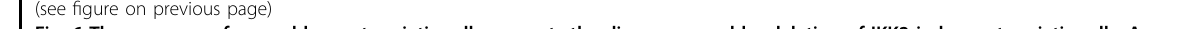
Fig. 6 The presence of normal haematopoietic cells prevents the disease caused by deletion of IKK2 in haematopoietic cells. A Experimental design of competitive reconstitution assay. E14 WT(IKK), IKK1 fl / fl or IKK2 fl / fl donor 1 foetal liver cells hemizygous for ROSA26 Cre-ERT2 (CD45.2 + ) were mixed with E14 donor 2 WT (CD45.1 + /CD45.2 + ) foetal liver cells at a 1:1 ratio, and co-transplanted into lethally irradiated WT (CD45.1 + ) recipient mice. Reconstitution of peripheral blood cells by the donor foetal liver cells was assessed by CD45.1/CD45.2 staining on day 28 post transplantation. Four weeks after transplantation, the mice were treated with tamoxifen via oral gavage on two consecutive days to delete the fl oxed target gene in 50% of the haematopoietic cells. Mice were then monitored for any signs of illness, such as weight loss and lethargy. Three weeks after initiation of treatment, mice were sacri fi ced, and blood and organs were collected for analysis. Peripheral blood and bone marrow were subject to fl ow cytometric analysis using the indicated surface markers. Organs were fi xed in 10% buffered formalin, sectioned and stained with haematoxylin and eosin and assessed microscopically. B Kaplan – Meier curve of mice of the indicated genotypes. C Comparison of mouse body weight before tamoxifen administration (gene deletion) and at the date of sacri fi ce. Values of individual mice are shown and data are expressed as means ± SEM of one independent experiment. D Differential white blood cell counts, E – G total white blood cell counts. E Neutrophil, F monocyte and G eosinophil count as assessed on the Hemavet blood analyser. Data are presented as means (D) and means ± SEM (E – G) from 8 mice of each genotype of one independent experiment. H Peripheral red blood cell count (RBC) and I platelet cell count (PLT). Individual values, mean and SEM are shown of one independent experiment with n = 8 mice for each genotype. J , K Flow cytometric analysis of total bone marrow harvested from mice of the indicated genotypes at the experimental endpoint. Percentages of J Lin − Sca-1 + c-Kit + (LSK) cells and (K) Lin − Sca-1 − c-Kit + (LK) cells among CD45.2 + cells in the bone marrow. The results are presented as means ± SEM from eight mice of each genotype of one independent experiment. L ELISA analysis of serum levels of IL-6 in mice of the indicated genotypes at the experimental endpoint. Data are shown as mean ± SEM of one independent experiment, including individual values with n = 8 mice for control and IKK1 deleted in 50% of the haematopoietic cells and n = 7 mice for IKK2 deleted in 50% of the haematopoietic cells. ns p > 0.05 as determined by one-way ANOVA (mouse weight p = 0.5956; neutrophils p = 0.3413; monocytes p = 0.7830; eosinophils p = 0.5920; RBC p = 0.1025; PLT p = 0.0940; LSK p = 0.9876; LK p = 0.4309; IL-6 p = 0.3313) and Dunnett ’ s multiple comparison